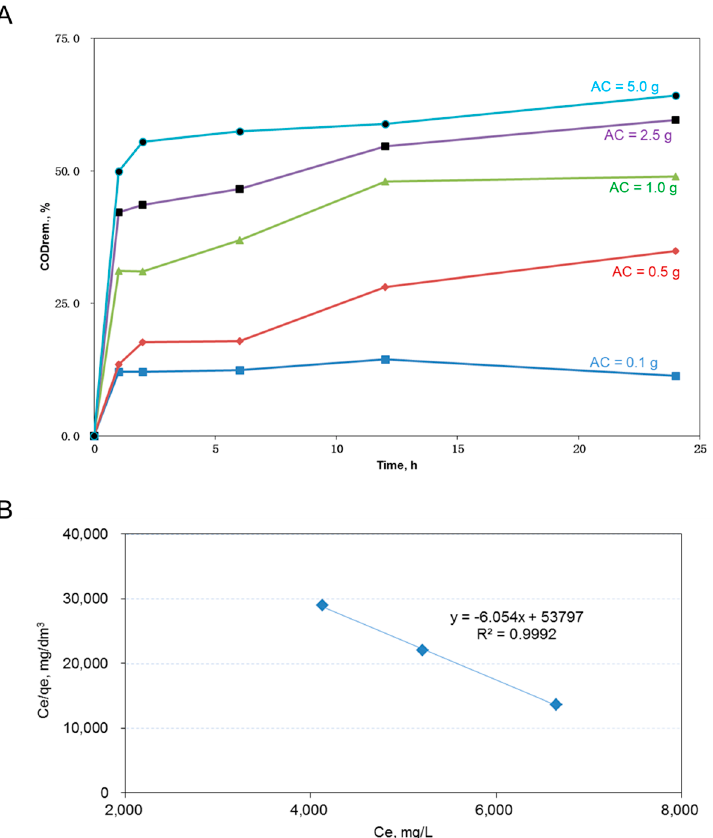
Figure 1. Adsorption characteristics of the used AC. ( A ) Plots of the percent COD removed versus the AC amount used in adsorbing the dyeing wastewater COD. ( B ) Plot of the Ce/qe ratio versus Ce. The maximum adsorption capacity (q max ) at 24 h in ( A ) was equal to 0.165 (calculated by 1/6.054) g-COD/g-AC.